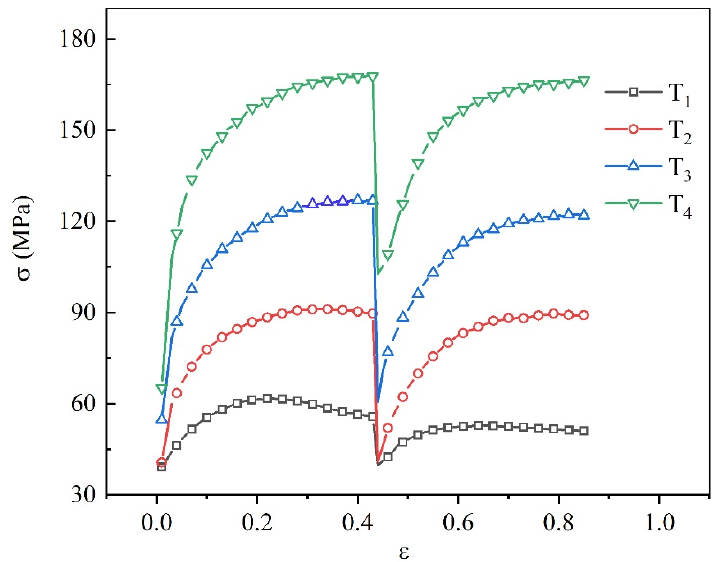
Figure 2. Stress–strain curves in double-pass compressions under different strain rates (T c = 1050 °C, (cid:2013) (cid:2869) = (cid:2013) (cid:2870) =0.43, (cid:1872) (cid:3035) =30